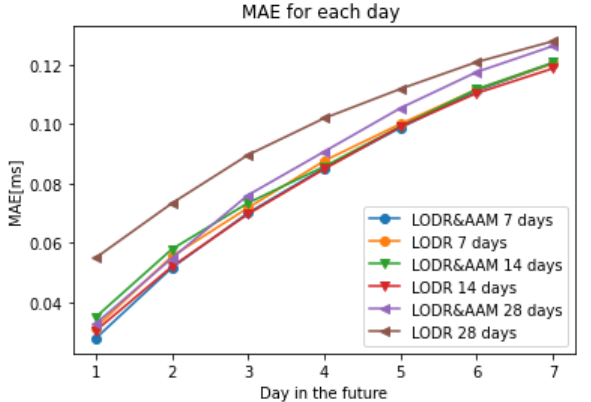
Figure 8. Mean absolute errors of the predicted LOD using the 1D CNN before and after introducing the AAM with different input sizes (7, 14, 28